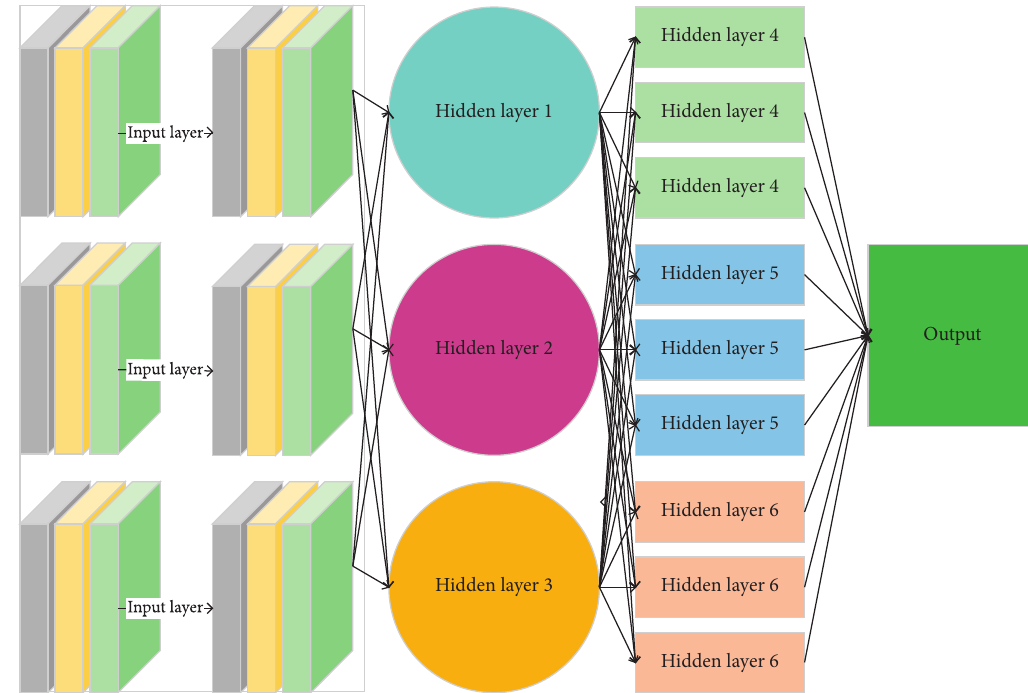
Figure 1: DenseNet network structure.